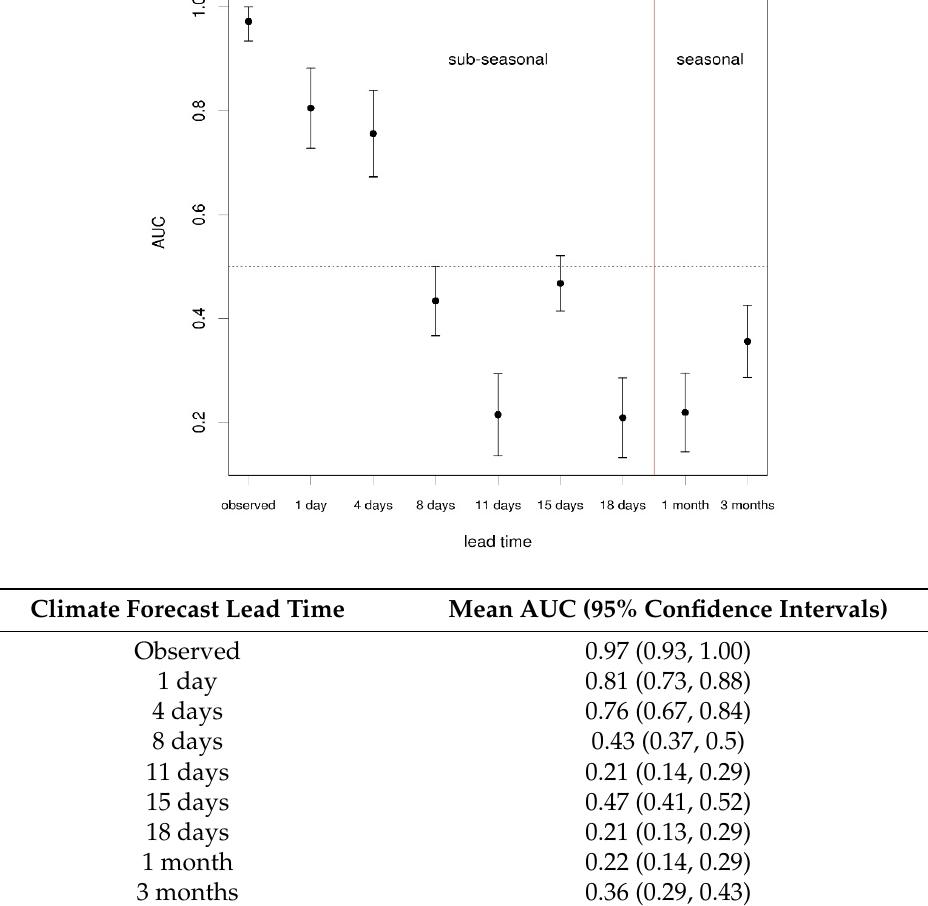
Figure 5. The ROC score or area under the ROC curve (AUC) and associated 95% confidence intervals for the binary event of exceeding the emergency mortality threshold of the 75th percentile in each of the 54 regions for the heat wave scenario (1 – 15 August 2003), using the probabilistic mortality model driven by forecast apparent temperature data at lead times ranging from 1 day, 4 days, 8 days, 11 days, 15 days, 18 days (sub-seasonal forecasts), 1 month and 3 months (seasonal forecasts). The AUC for the mortality model driven by observed apparent temperature data is shown for reference. The dotted horizontal line indicates the skill threshold of AUC = 0.5. The red vertical line distinguishes lead-times at sub-seasonal (less than a month) and seasonal (greater than a month) time scales. Results are also displayed in the accompanying table.